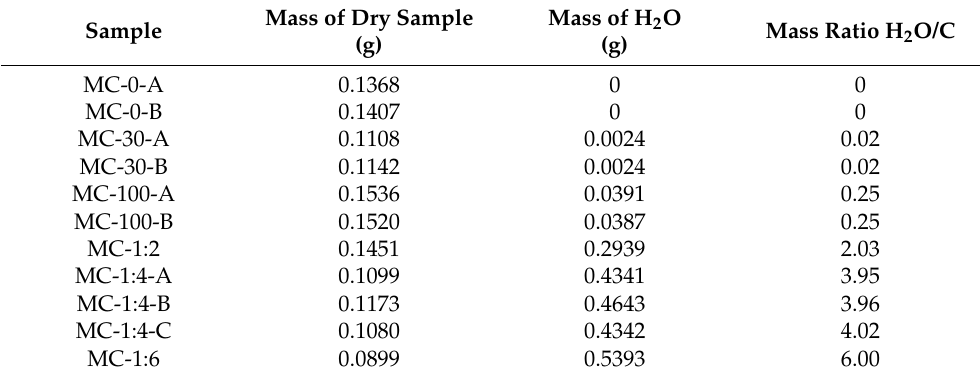
Table 1. Preparation parameters of all investigated